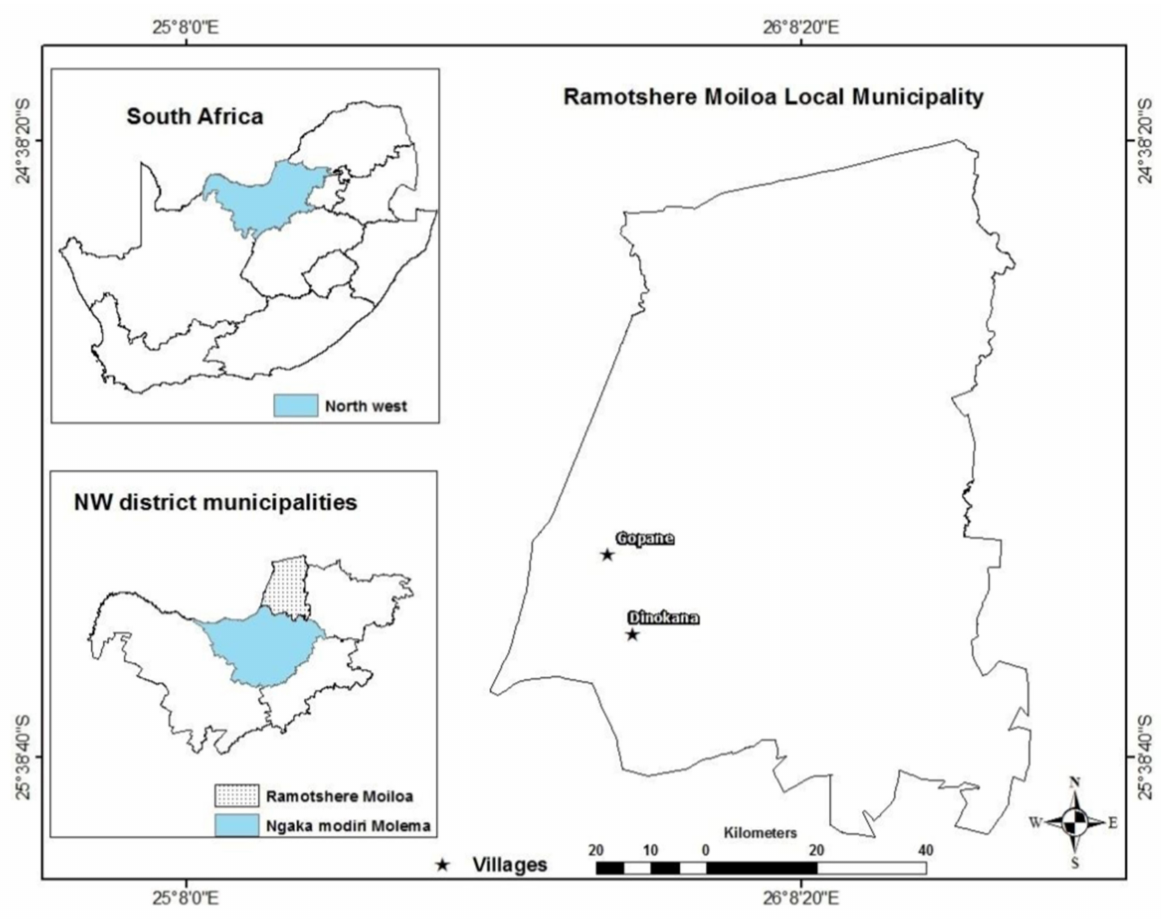
Figure 5. Location of the Dinokana and Gopane villages in the Ramotshere Moiloa local municipality, North West Province, South